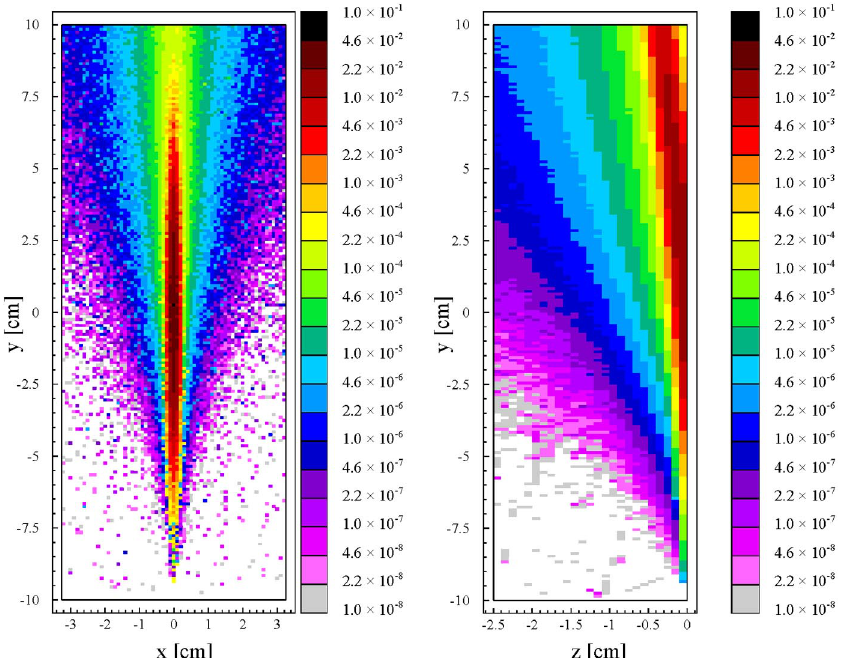
FIG. 6. (Color) Temperature increase # T (in kelvin) calculated for the Cu = graphite collimator bombarded under 35 mrad grazing angle with (cid:7) 1 : 5 (cid:2) 10 6 In 49 (cid:1) ions at 158 GeV = u . Left: # T in the uppermost 1 : 5 (cid:4) m copper layer ( x - y plane); right: # T across the collimator ( z - y plane) at x (cid:4) 0 .